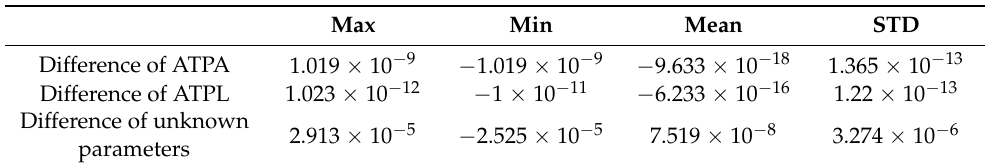
Table 4. Statistics of the difference between the matrix elements of the parallel method and those of the non-parallel method.